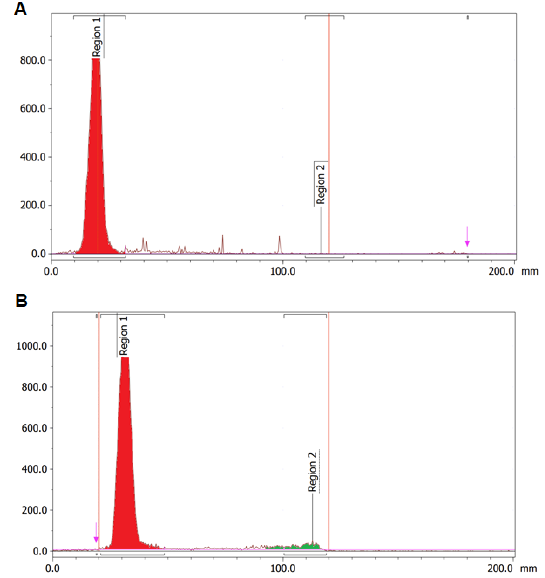
Figure 9. Radiolabelling efficiency using radio-ITLC for radiolabelling of ( A ) 177 Lu and ( B ) 64 Cu to 120-day old DOTA-C595.